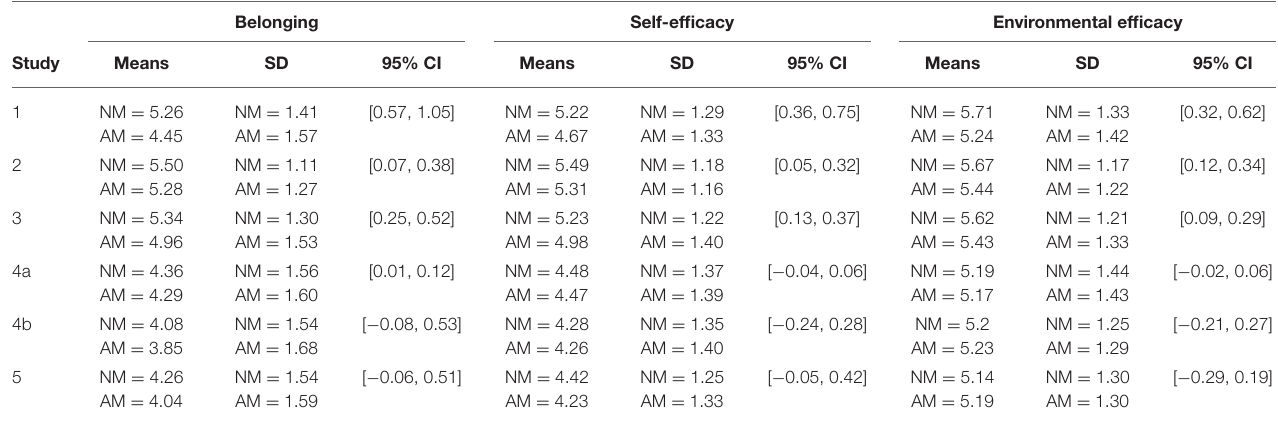
Belonging Self-efficacy Environmental